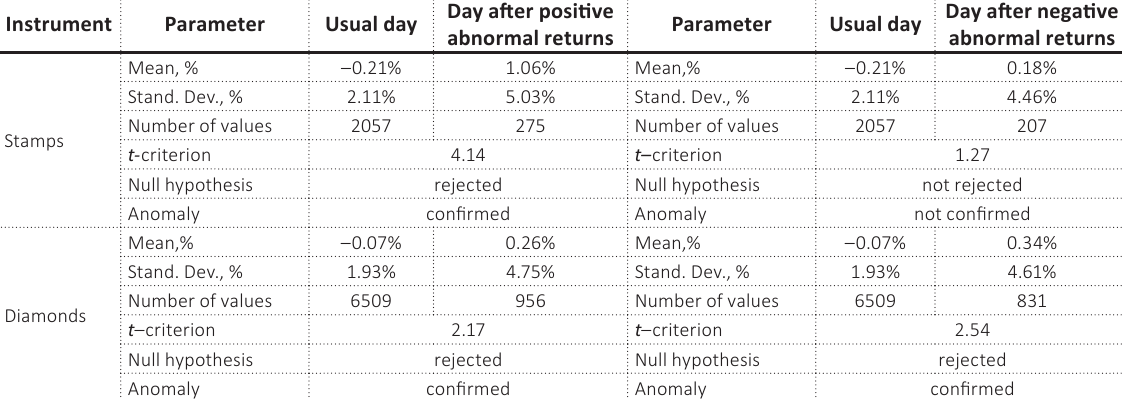
Table A2. T -test